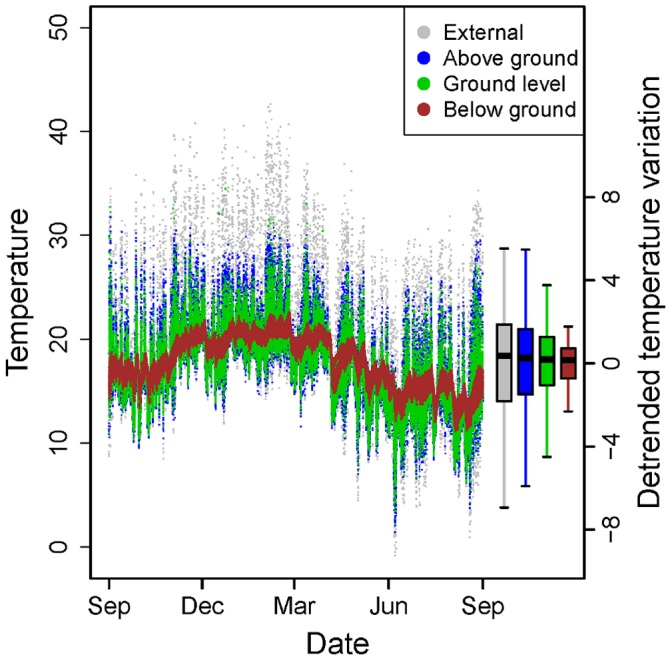
Annual variation in external air temperature (°C) and temperature inside forest at three different height strata.Points represent a single recording, taken every three hours for a 12 month period (September 1, 2009 to August 31, 2010) at 73 locations in the Brazilian Atlantic forest biome. Boxplots on the right show the residual variation in temperature after detrending. Thick lines represent the median, the box represents the upper and lower quartiles and the whiskers represent the maximum and minimum points that are no more than 1.5 times the interquartile range.